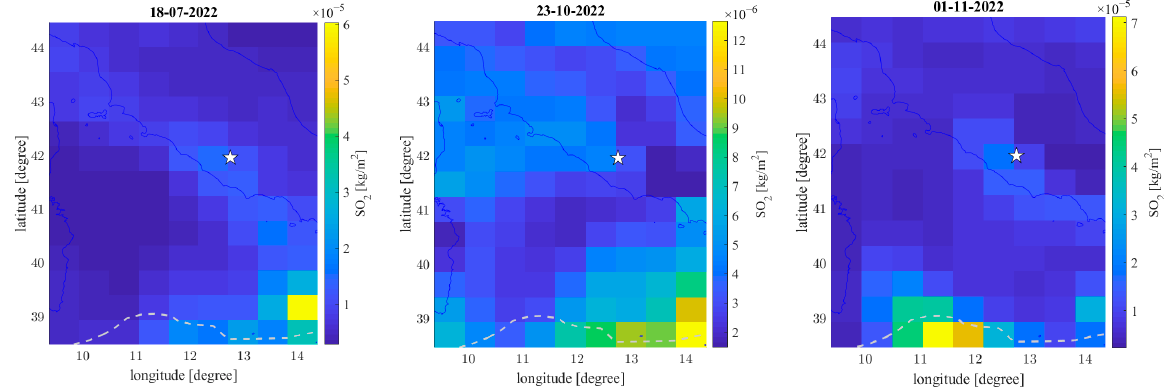
Figure 6. SO 2 maps on 17 July, 23 October and 1 November 2022. The epicentre of Guidonia 1 Janu- ary 2023 earthquake is shown with a white star.